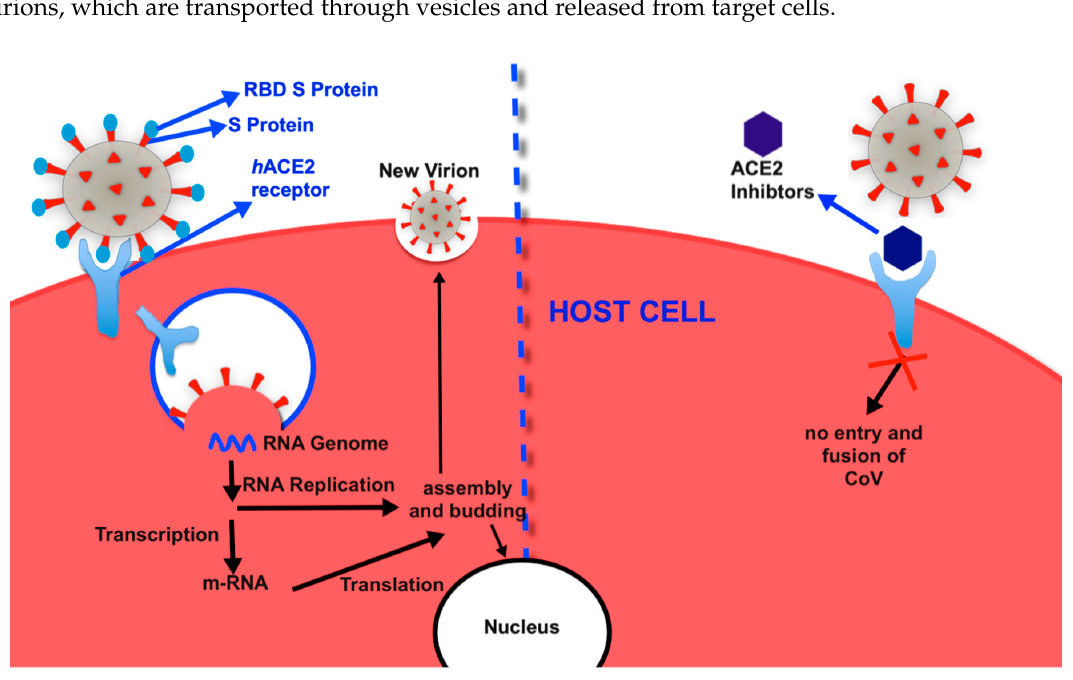
Figure 3. The life cycle of SARS-CoV. The spike (S) protein of SARS-CoV binds with the angiotensin- converting enzyme 2 (ACE2) receptor to enter host cells and release the RNA genome into the target cells. Structural and nonstructural proteins of CoV and the RNA genome assemble into virions, which are released from target cells.